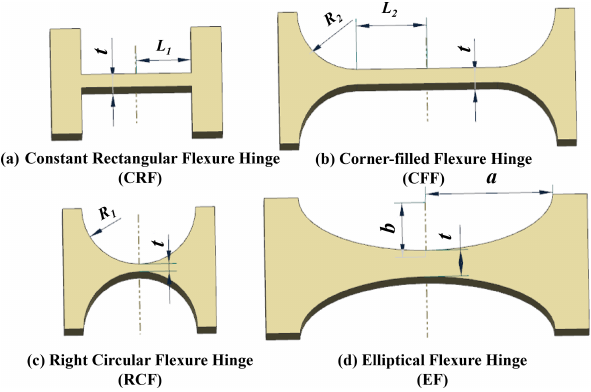
Figure 2. Four types of commonly used flexible hinges.